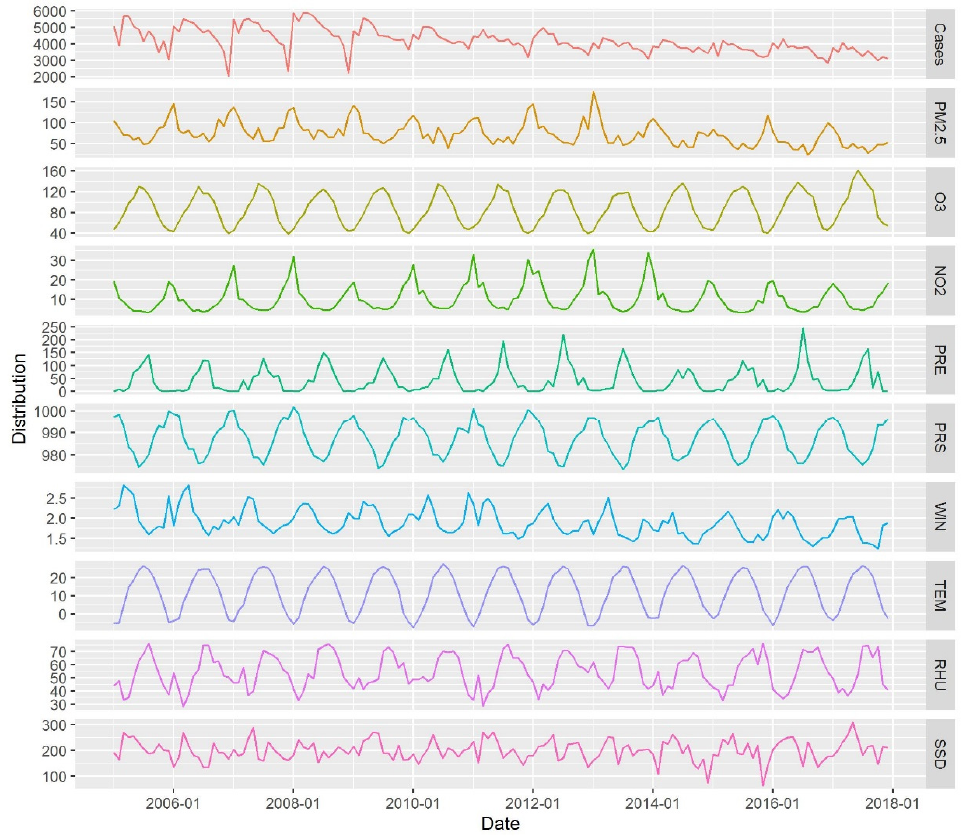
Figure 3. Monthly variations in the number of pulmonary tuberculosis (PTB) cases, air pollutant concentrations, and meteorological factors in Beijing–Tianjin–Hebei region. Table 3. Summary statistics of the number of pulmonary tuberculosis (PTB) cases, air pollutant con- centrations, and meteorological factors in the Beijing–Tianjin–Hebei region.